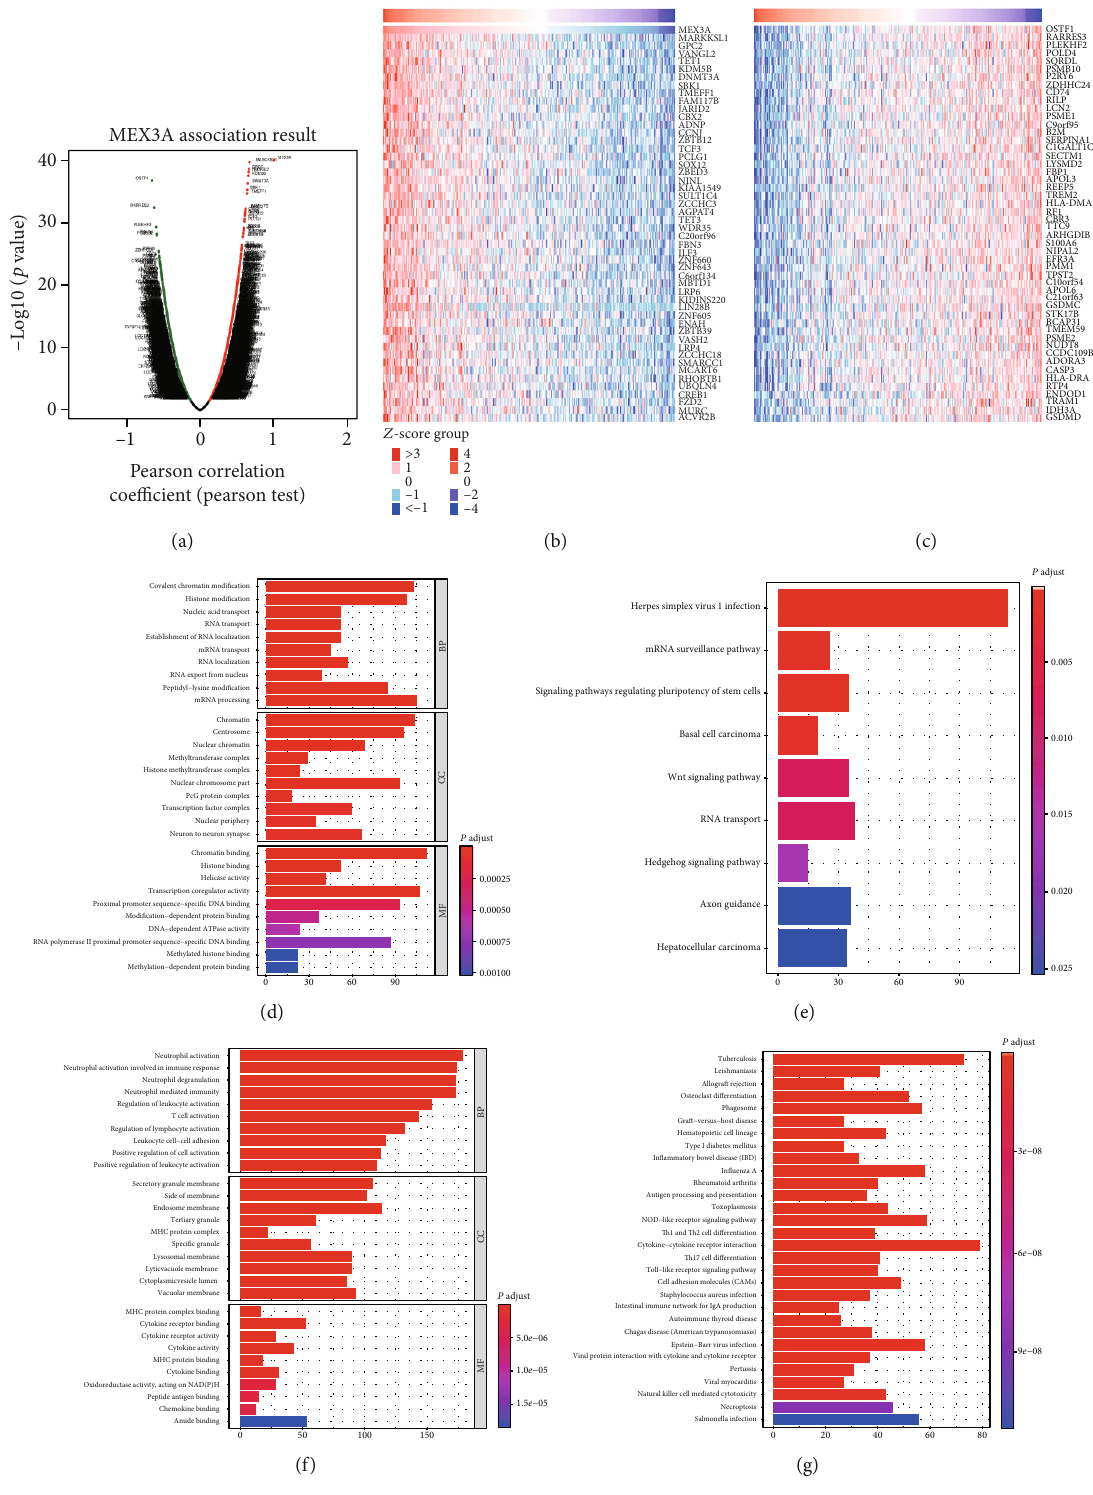
Figure 4: Genes di ff erentially expressed in correlation with MEX3A (LinkedOmics). (a) Correlations between MEX3A and genes di ff erentially expressed in OC. (b) Heat maps showing genes positively and negatively correlated with MEX3A in OC (Top 50). (c) Heat maps showing genes negatively correlated with MEX3A in OC. Red indicates positively correlated genes, and blue indicates negatively correlated genes. (d) Barplot representing enriched functions of the upregulated genes coexpressed with MEX3A. (e) Barplot representing enriched pathways of the upregulated genes coexpressed with MEX3A. (f) Barplot representing enriched functions of the downregulated genes coexpressed with MEX3A. (g) Barplot representing enriched pathways of the downregulated genes coexpressed with